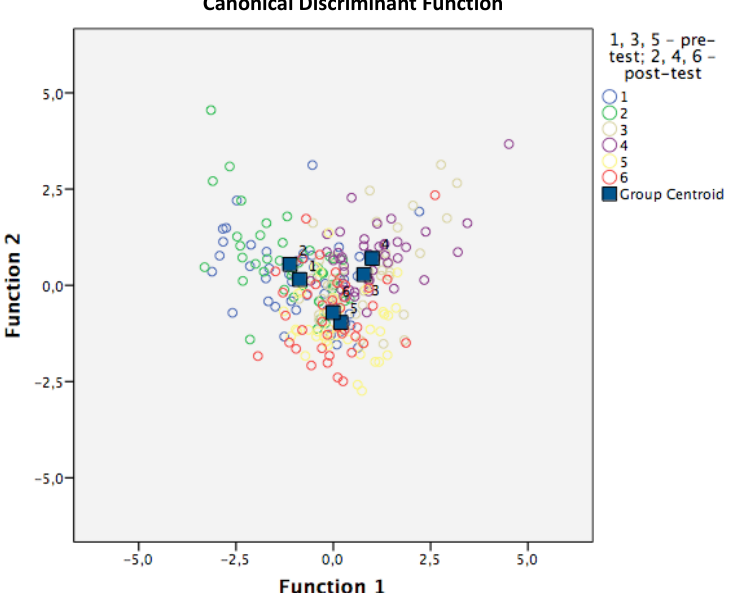
Fig. 1. Indicators of female students’ fitness depending on sports specialization: 1, 2 – badminton; 3, 4 – aerobics;